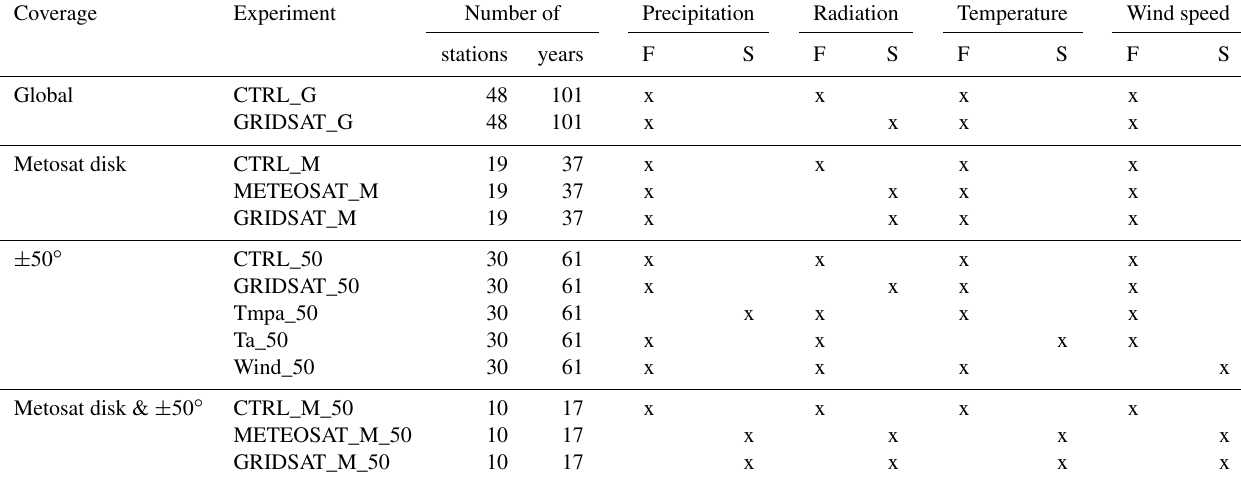
Table 2. List of performed model experiments. Includes the number of stations and station years as well as the data source: F is FLUXNET data; S is satellite data for precipitation and radiation; additional data from satellites for albedo and LAI, and from ECMWF reanalyses for temperature, total column water vapor, and wind speed. Coverage Experiment Number of Precipitation